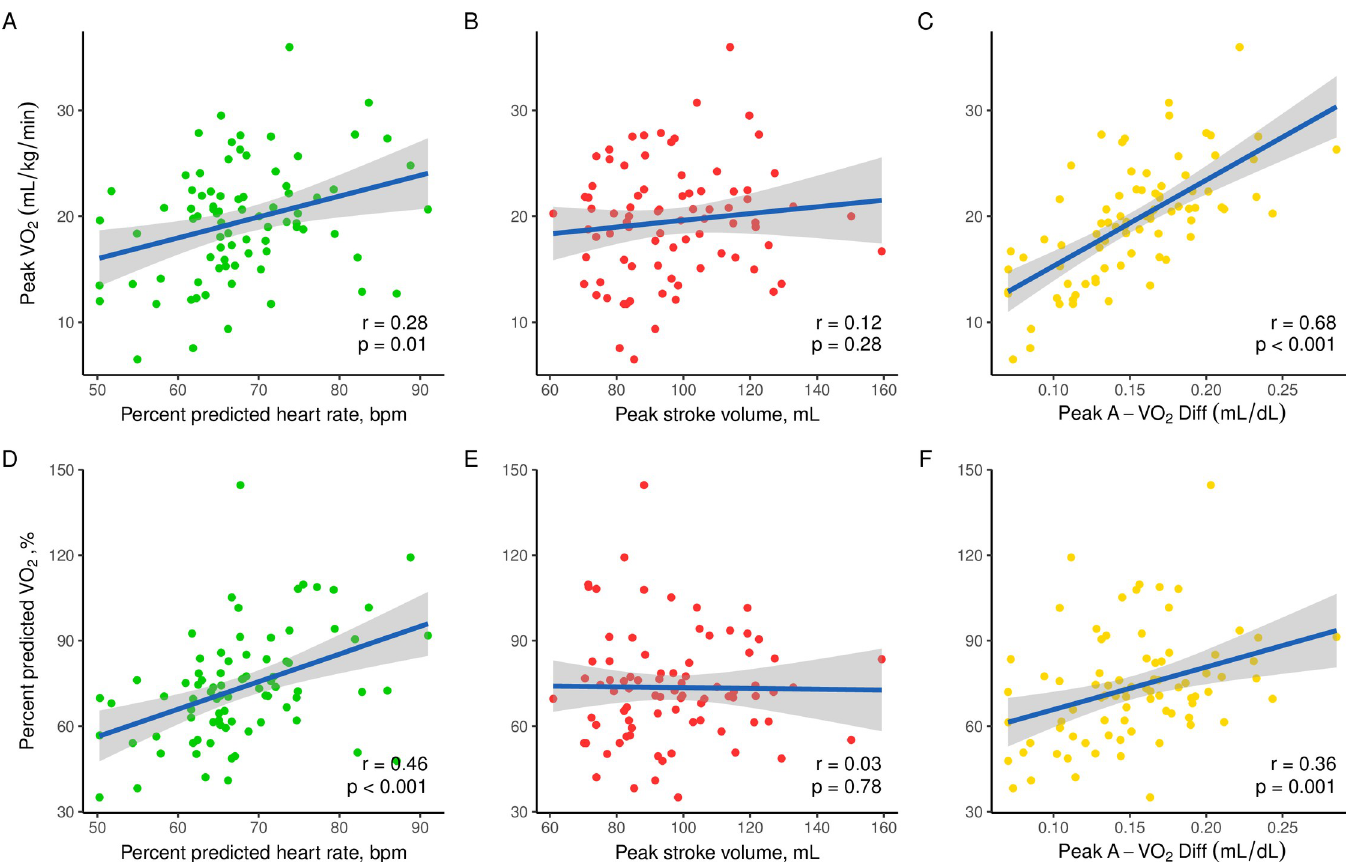
Fig 2. Linear regression between peak oxygen uptake, percent predicted oxygen uptake and percent predicted heart rate, peak stroke volume, and peak arteriovenous oxygen difference in the whole studied group. Abbreviations: A-VO 2 Diff, arteriovenous oxygen difference; VO 2 , oxygen uptake.